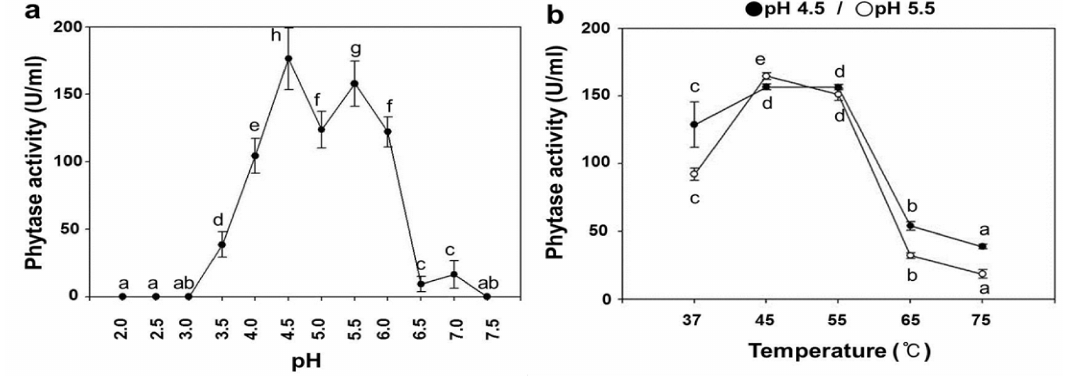
MES (pH 6.0–6.5) and 50 mM HEPES (pH 7.0–7.5); ( b ) The effect of temperature on